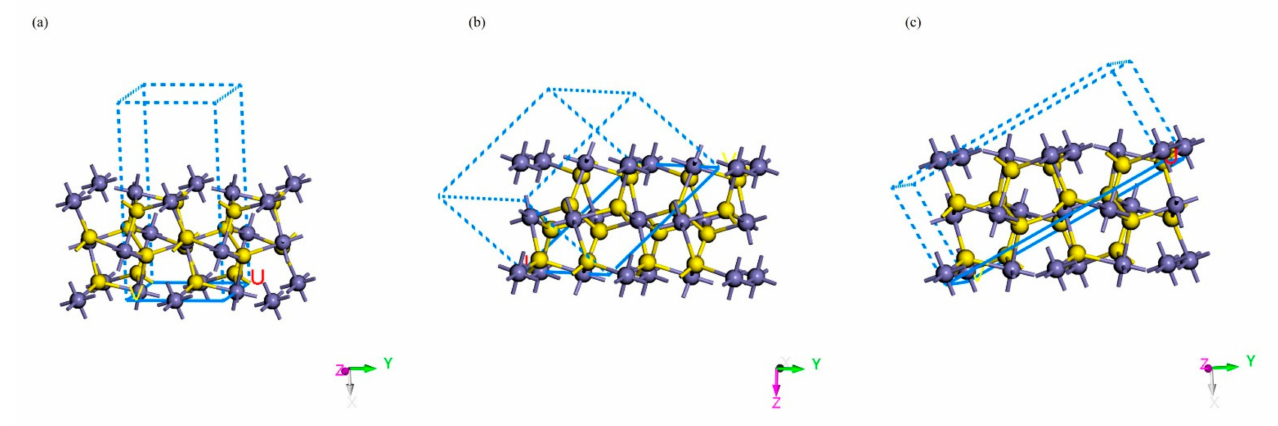
Figure 1. Pyrite crystal cleavage sites: ( a ) (100) Surface cleaved sites; ( b ) (111) Surface cleaved sites; ( c ) (210) Surface cleaved sites. (The yellow ball: S; the blue ball: